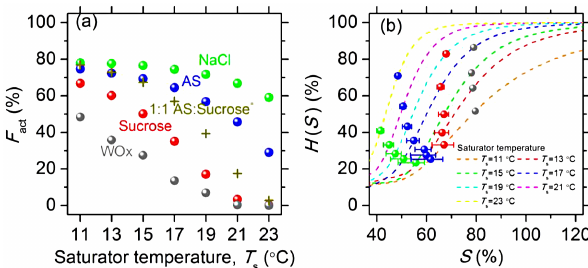
Figure 8. (a) Activation fractions for 2.5nm NaCl (green), AS (blue), sucrose (red) and WOx (gray) aerosols as a function of sat- urator temperature T s . The mixed AS and sucrose (yellow, mass ratio is 1 : 1) aerosols is also shown. Note the experiment of mixed aerosols was done afterwards; hence, it might not represent the real case exactly due to the varied H(S) inside the nano-CCNC; (b) cal- culated critical supersaturations (filled symbols) for various chem- ical compounds based on the determined H(S) (Fig. 6b) and mea- sured F act (Fig. 8a). The colored dash lines indicate the cumulative supersaturation distributions inside the nano-CCNC at different T s . The whisker represents the standard deviation caused by the elec- trometer counting. Note the points with uncertainties of S higher than 10% are excluded.